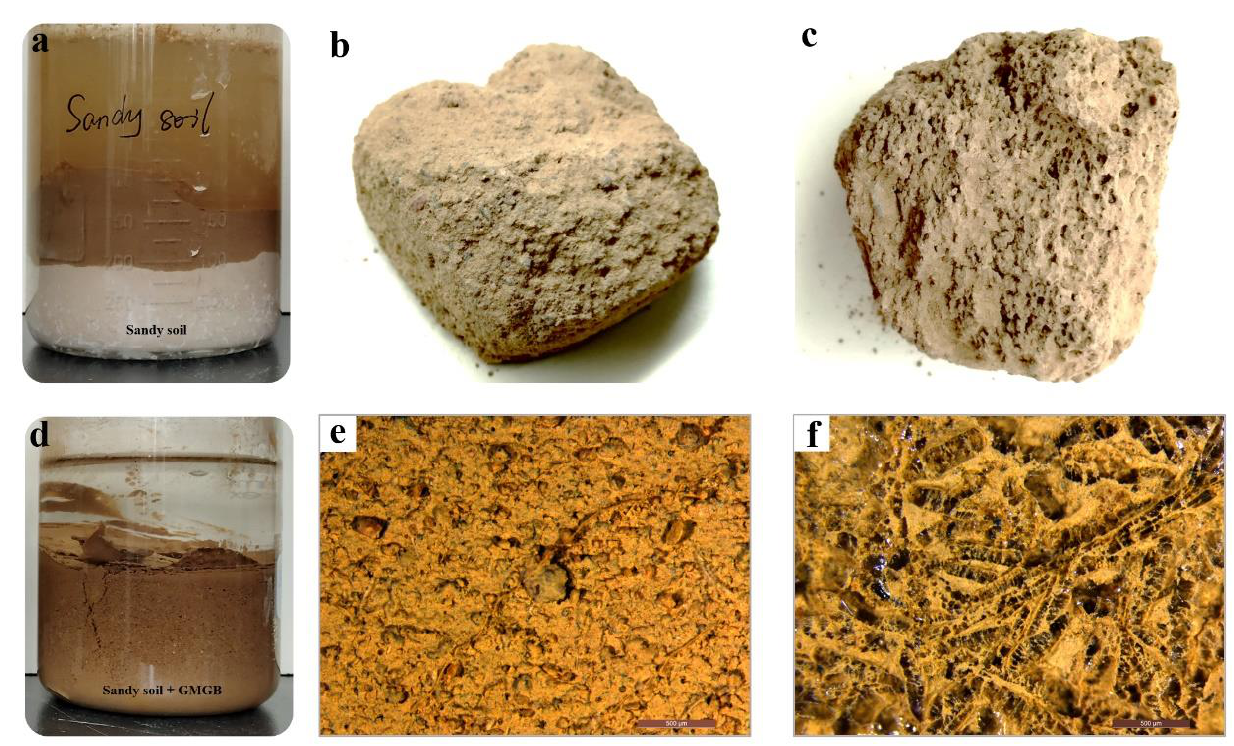
Figure 4. ( a ) The sandy soil absorbs water slowly; ( b ) dried sandy soil; ( c ) dried sandy soil – GMGH; ( d ) the sandy soil with GMGB absorbs water quickly; ( e ) enlarged SZM image of the sandy soil; ( f ) enlarged SZM image of the sandy soil – GMGH.